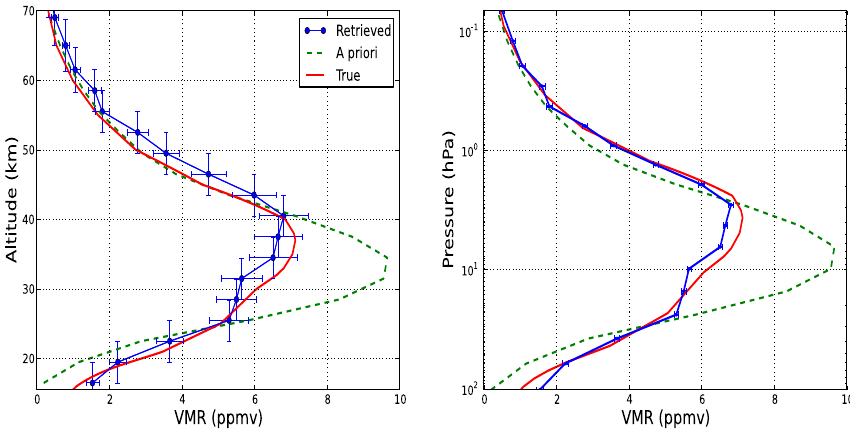
Fig. 13. Simulation of the A/B-w1 inversion process. The retrieved O 3 profile is plotted as a function of altitude levels (left panel) and of pressure levels (right panel). Atmospheric profiles for simulating the measurement vector are from a winter mid-latitude climatology and from a tropical climatology for the reference/a priori profiles. In addition, the true pressure profile was multiplied by 0.95 and a noise of 0.4K (1- σ ) was added to the measurement vector. In the left panel the vertical bars indicate the full-width-at-half-maximum of the averaging kernels and the horizontal bars are the 1- σ measurement noise and the pressure-induced error (Fig. 9). In the right panel the horizontal bars are for the 1- σ measurement noise.